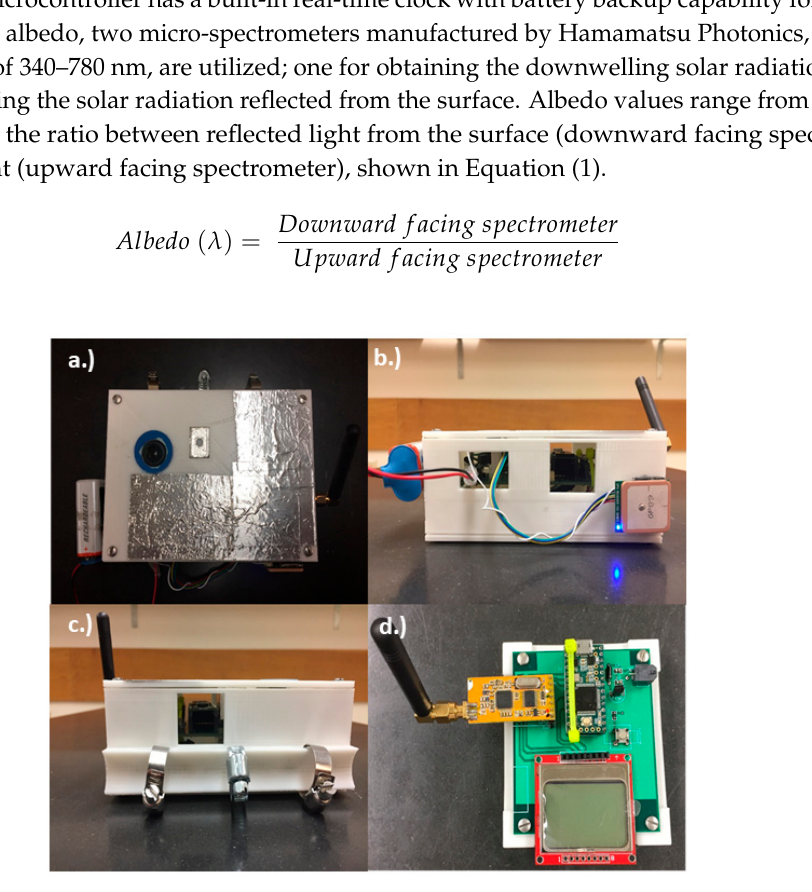
Figure 1. Albedometer design: ( a ) Top view of measuring device showing upward facing spectrometer and camera. Aluminum tape was added to maintain cool temperatures inside the box and an ultraviolet (UV)/infra-red (IR) filter was placed over the camera to capture more natural looking images; ( b ) Side view of measuring device showing the Global Positioning System (GPS) and 9 V battery which sit outside of the box; ( c ) Side view of measuring device showing the custom 3D-printed mount built-in to the box; ( d ) Ground control device showing radio for communicating to the measuring device, a button for initiating measurements, a screen for printing resulting albedo in real-time, and the Teensy 3.2